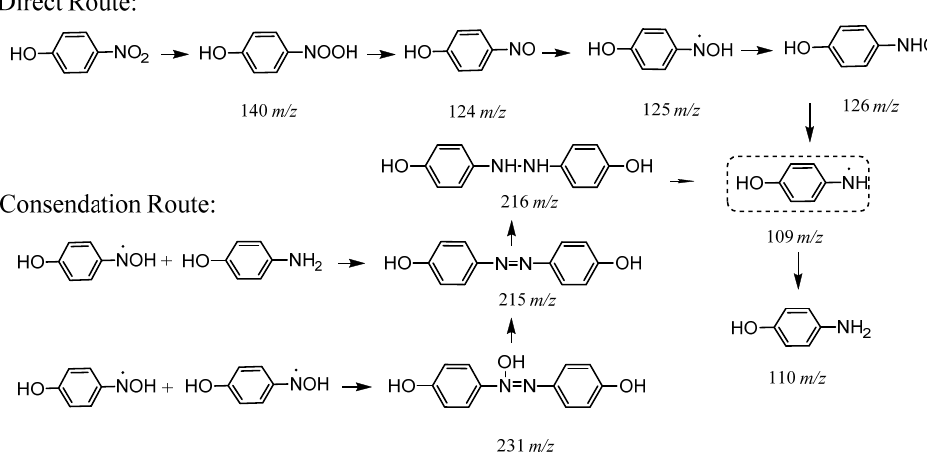
Figure 5. The reaction mechanism for Co(OH) 2 /CuO catalytic reduction of 4-nitrophenol in presence of NaBH 4 under nitrogen atmosphere.